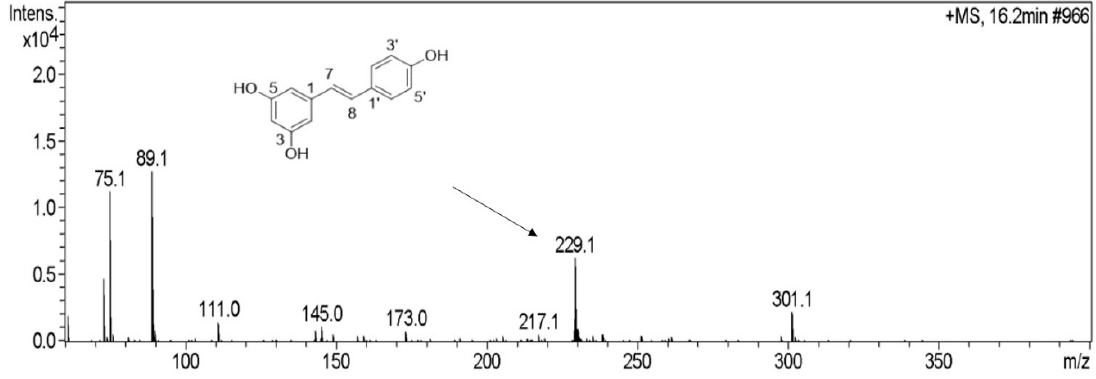
Figure 3. Mass spectrum of biotransformation product under positive ionization mode.